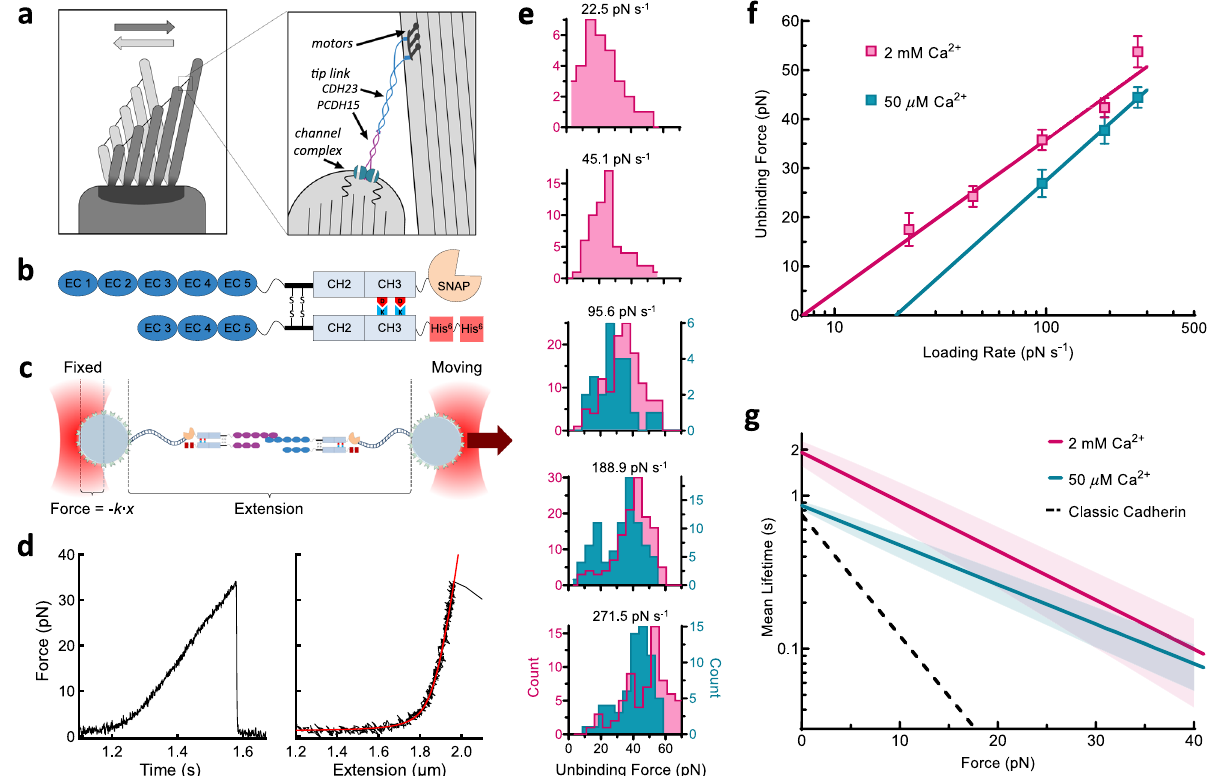
Fig. 1 The mechanical strength of a single tip-link bond. a The hair-cell stereocilia bundle and mechanotransduction complex. Bundle de fl ection to the right increases tension on tip links, composed of CDH23 and PCDH15. Here and throughout, PCDH15 is shown in purple and CDH23 in blue. b Single-bond fusion proteins containing one EC1-2 binding domain. Antibody Fc domains (CH2, CH3) fused to the EC domains bind to create a dimer, masking non- speci fi c binding of EC3-5. The SNAPtag binds to the DNA tether. c Single-bond fusion proteins in the dual-beam optical trap. Force was calculated as a linear function of displacement from a stiffness-calibrated optical trap. The extension was measured as the distance between the surfaces of the two microspheres. d Representative force-time and force-extension pro fi les for a single-bond unbinding event. The force-time pro fi le was used to extract the force-loading rate in pN s − 1 in the linear regime preceding bond rupture. The force-extension pro fi le was fi t with an extensible worm-like chain (WLC) model 95 to extract contour length, persistence length (related to bending stiffness), and unbinding force for each unbinding trace. e Histograms of unbinding forces at different force-loading rates in 50 µ M (cyan) and 2 mM (pink) Ca 2 + . f Most-probable unbinding forces plotted as a function of loading rate. Systematic kernel density estimation was used to determine the most likely unbinding force for each condition. Error is shown as the optimal bandwidth from a kernel density estimation. A weighted linear fi t of the data with the Bell – Evans model was used to extract force-dependent unbinding kinetics 39 , where f β is the slope and k off 0 ∙ f β is the x -intercept. For 50 µ M Ca 2 + , n = 174 unbinding events, and for 2 mM Ca 2 + n = 411 unbinding events. g Mean single-bond lifetime as a function of force, calculated using the intrinsic zero-force off rate k off 0 and the force scale f β from f , and compared to the average lifetime of classic cadherin bonds (dashed black line) 21 – 25 . The propagated errors in lifetime due to errors in fi t parameters from f are shown as light